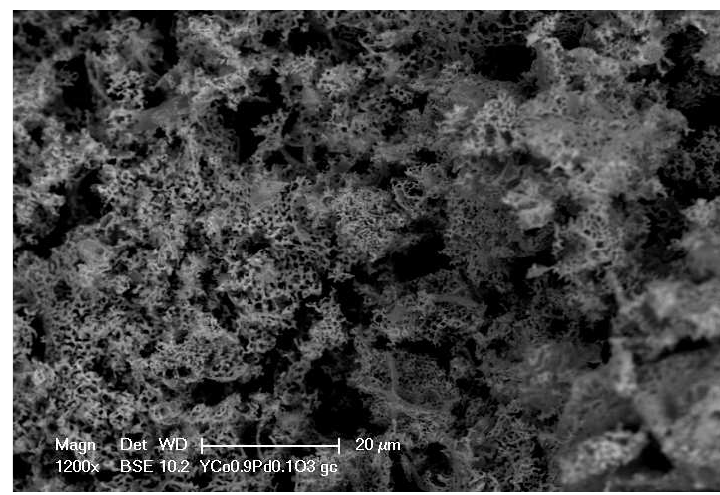
Figure 2. SEM: morphology analysis of Mt1. Details of spongy structure at 1200 × .